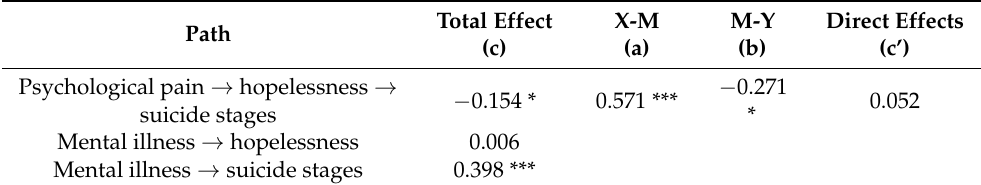
Table 4. Bootstrap mediation effect test results ( β